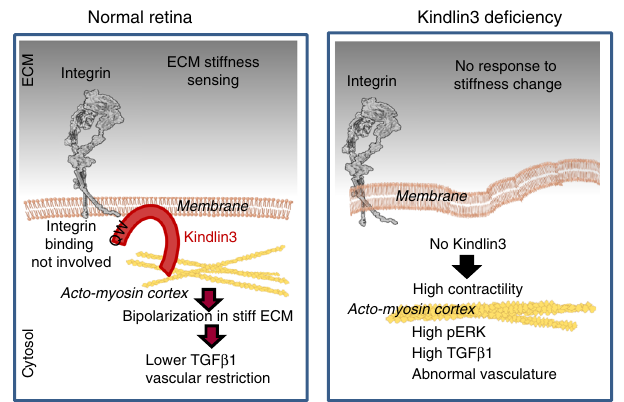
Fig. 8 Schematic summarizing the main fi ndings. Kindlin3 is an intracellular integrin-binding adaptor molecule containing 3 FERM (F1, F2, and F3) domains and a PH domain. Kindlin3 binds integrins via its F3 subdomain and to the plasma membrane phospholipid, PIP2, through its PH domain. The FERM domains also interact with numerous cytoskeletal proteins and adaptors. ERK localizes to the actin cytoskeleton and is phosphorylated exclusively on actomyosin bundles in a myosin-II- dependent manner. Actomyosin bundles serve as a scaffold for activation of ERK signaling. In the absence of Kindlin3, the cytoskeletal network is dissociated from the membrane, resulting in contraction of myosin in the center of the cell. High myosin contractility leads to ERK phosphorylation, eventually resulting in overexpression of TGF β